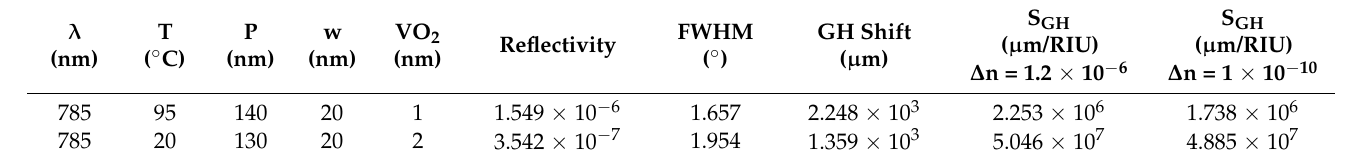
Table 1. Summary of the best configurations, when the metasurface thickness is 20 nm on top of a 30 nm continuous gold film. The results are classified according to excitation wavelength, temperature, periodicity and width of the nanogrooves, thickness of VO 2 , minimum reflectivity, FWHM, GH shift, and GH sensitivities, for ∆ n = 1.2 × 10 − 6 RIU and ∆ n = 10 − 10 RIU.